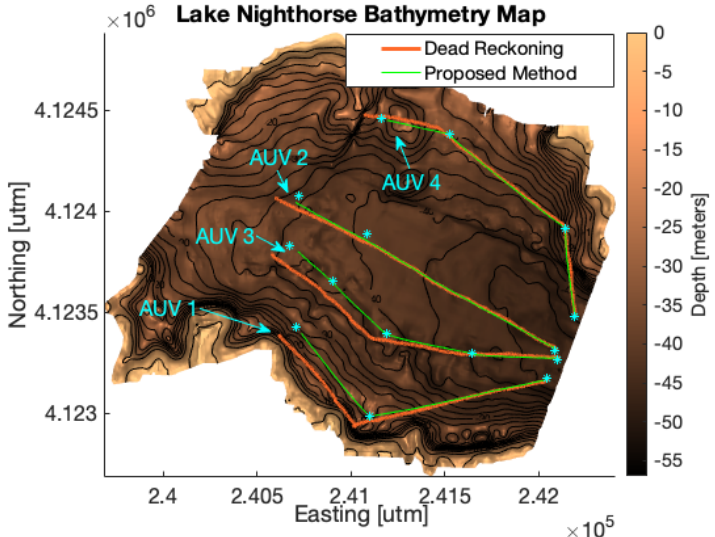
Figure 2. AUV paths through the simulated environment of Lake Nighthorse, CO. The blue stars are the AUVs’ waypoints. The green lines are the actual paths of the AUVs when using decentralized terrain-based navigation (dec-TBN), and the orange lines are the actual paths of the AUVs when using dead reckoning. Cooperative TBN leads to more accurate path following (closer to the waypoints) even in areas where the terrain is flat. The AUVs travel approximately 1.5